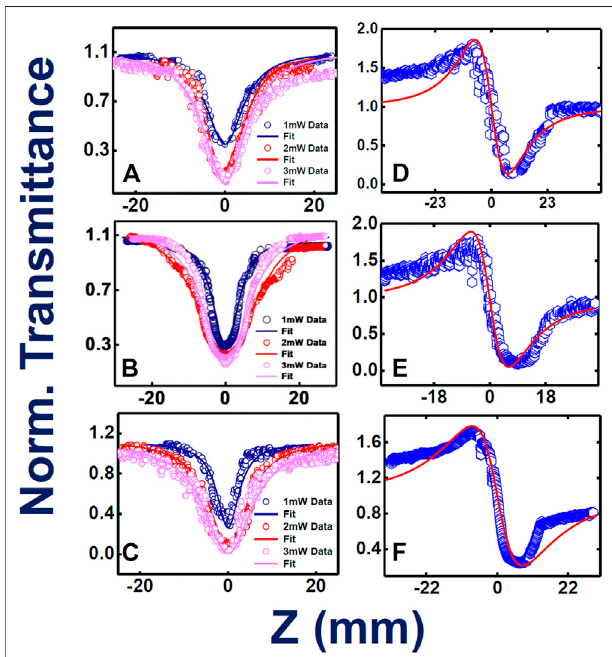
FIGURE 4 | Femtosecond MHz pulses experimentally and theoretically fi tted Z-scan data (intensity dependent) open aperture (A – C) and closed aperture con fi gurations (D – F) for TMPc , Cu-TMPc , Zn-TMPc , respectively, in solution form. Open symbols are the experimental data while the solid lines represent theoretical fi